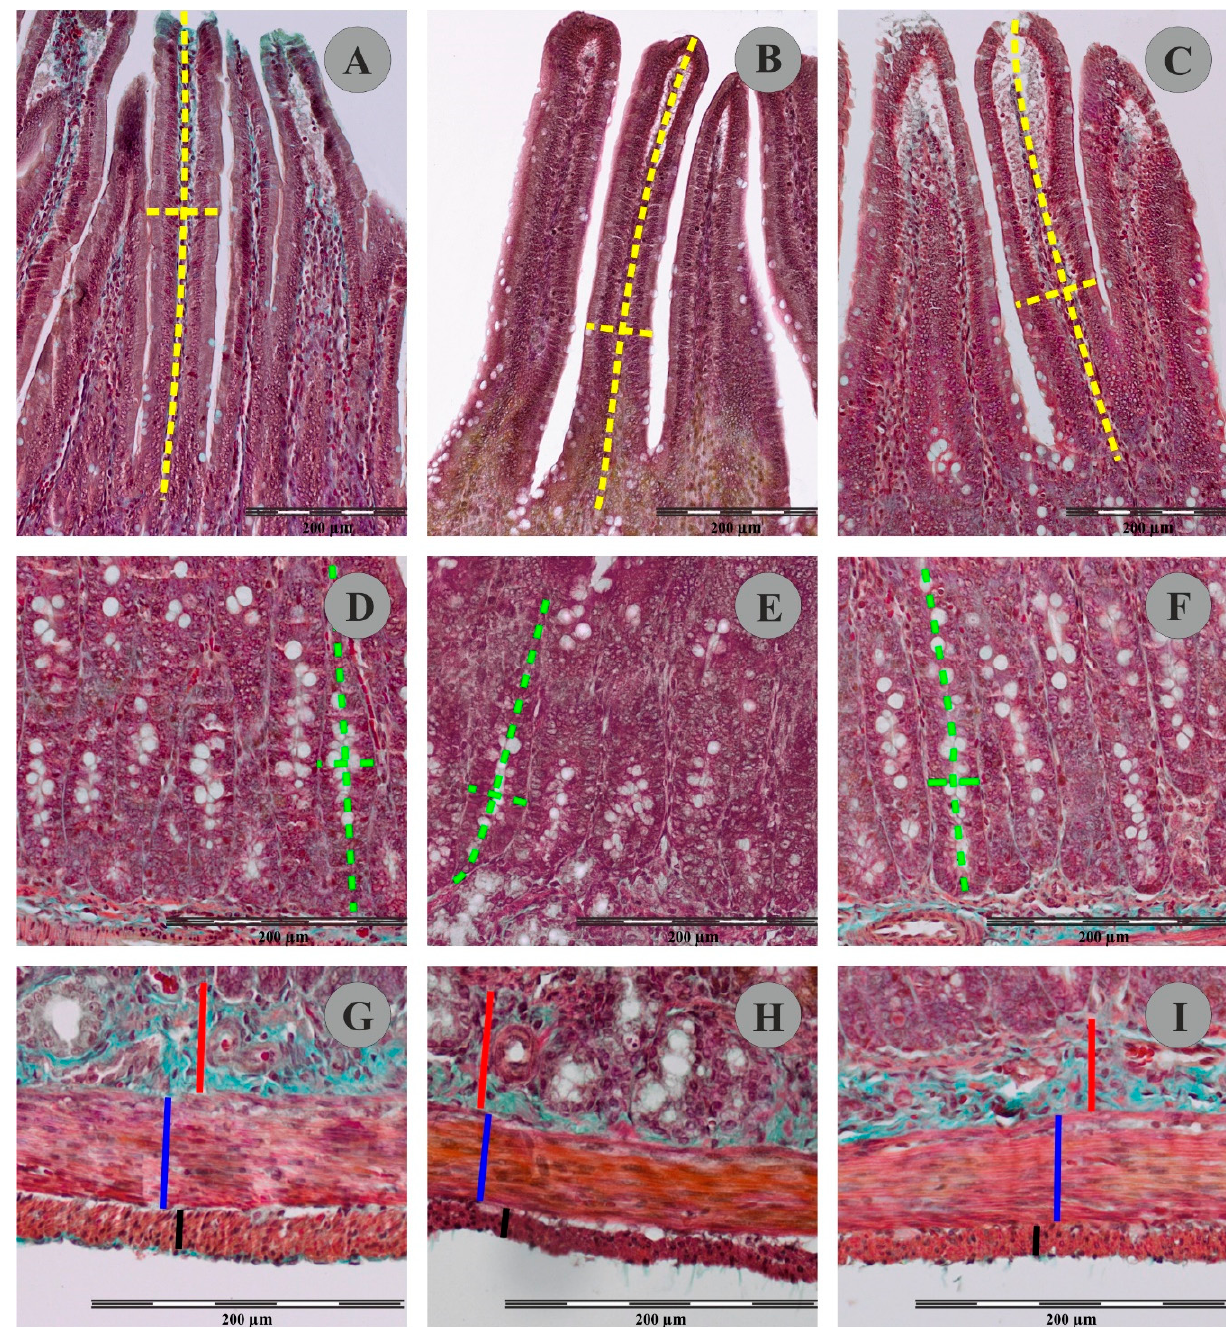
Figure 3. Representative pictures of villus ( A – C ); crypts ( D – F ) muscular and submucosal layer ( G – I ) in Goldner’s trichrome stained sections of rat duodenum from the control group ( A , D , F ), FB 60 group ( B , E , H ) and FB 90 group ( C , F , I ). Please note measurement schemes of the length (a long dashed yellow line) and the thickness (a short dashed yellow line) of the villus, the depth (a long green dashed line) and the width (a short green dashed line) of the crypts, the thickness of the submucosal layer (a continuous red line) and the thickness of the the circular muscle layer (a continuous blue line) and the thickness of the longitudinal muscle layer (a continuous black line).